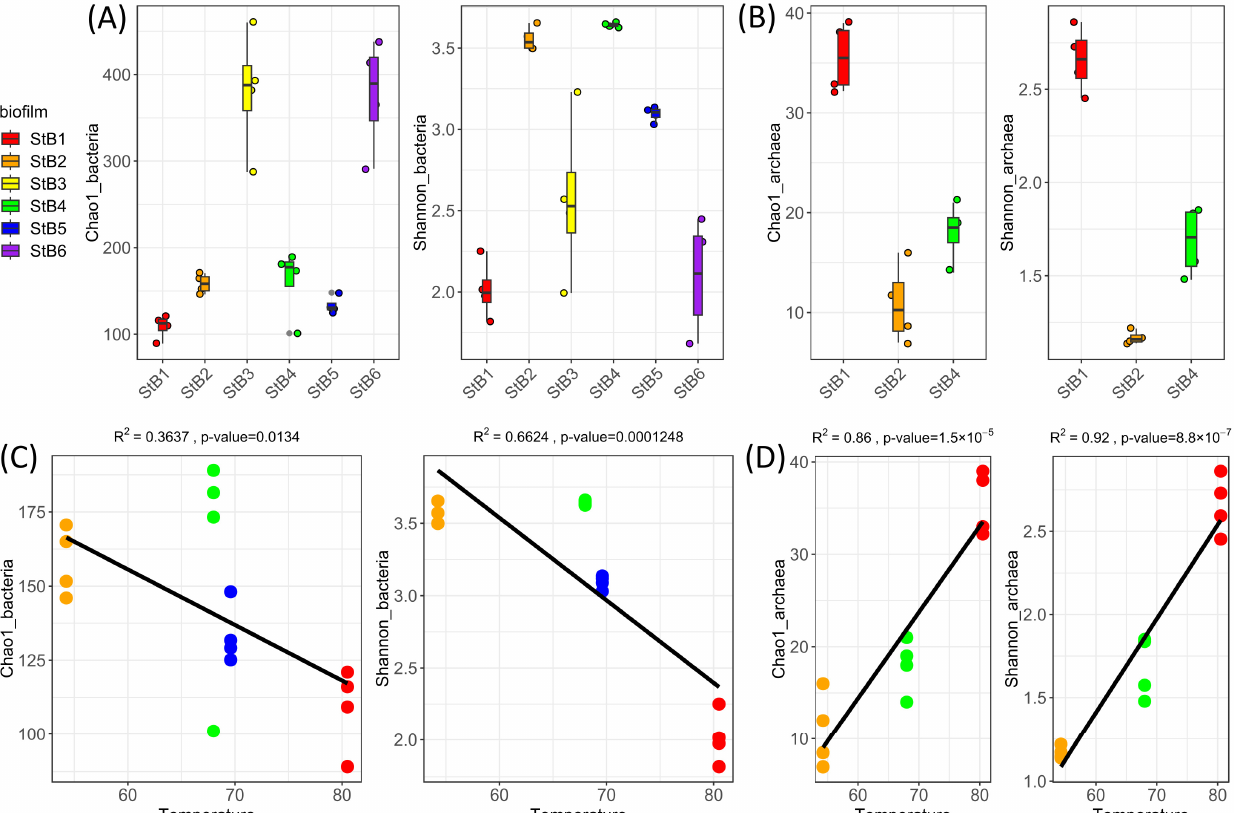
Figure 2. The alpha diversity measurements of the bacterial ( A ) and archaeal ( B ) components of the microbial commu- nities and linear regression analysis between diversity indices and temperature for bacteria ( C ) and archaea ( D ). Each biofilm is marked by a certain color identical for all